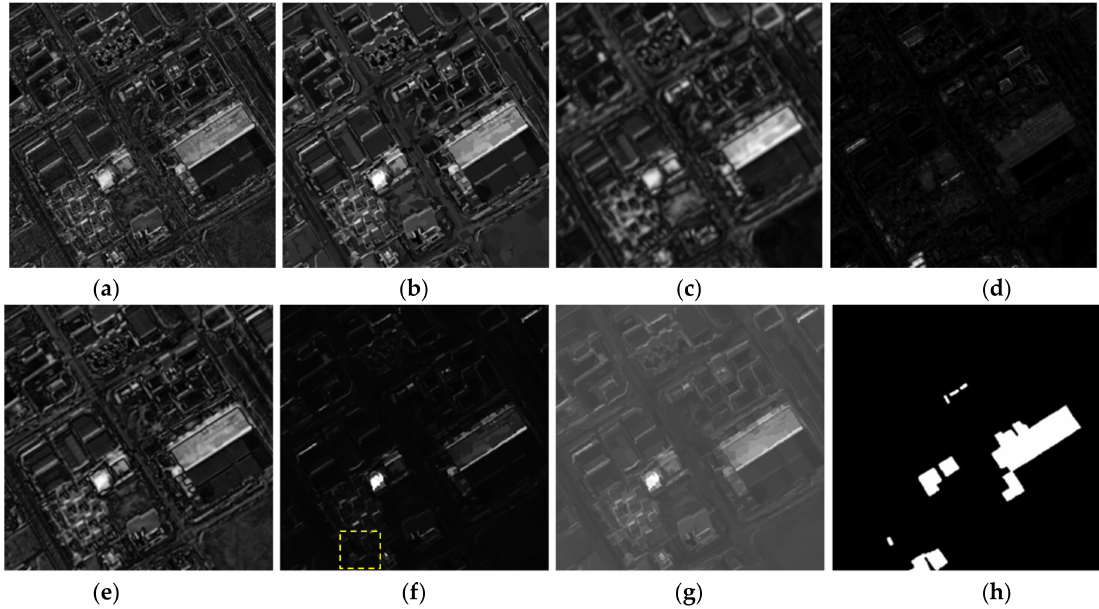
Figure 9. DIs of the second patch example of B&T data set generated by different methods: ( a )